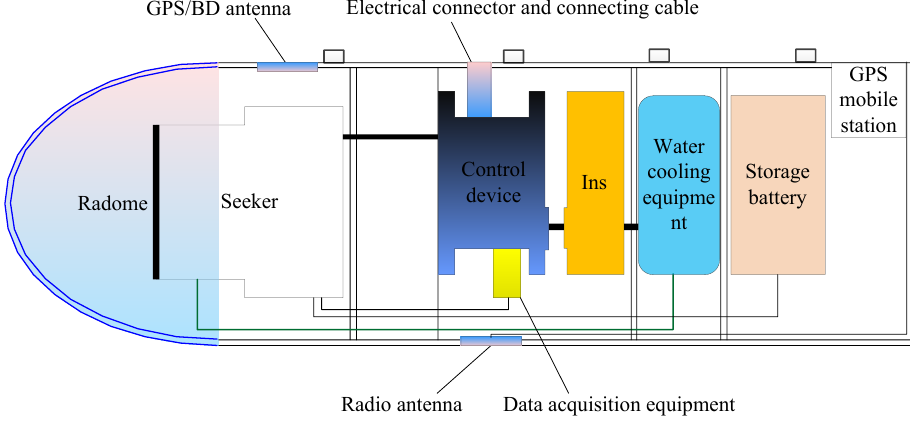
Figure 7. Composition of the pod.